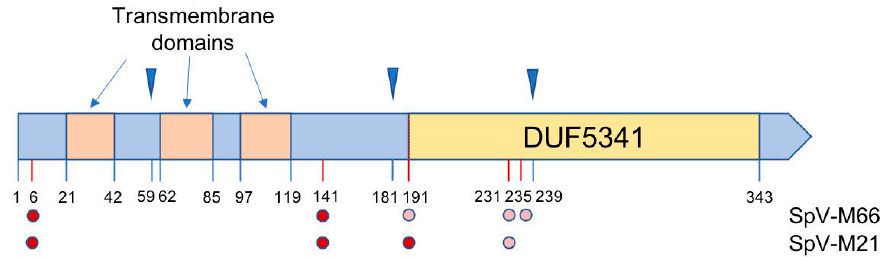
Figure 3. Features of the protein coded by SpV-M66. Blue triangles above the picture mark Kex2 sites. Predicted transmembrane domains and DUF5341 conservative Pfam family domain are marked within the picture. Dots below the picture mark putative glycosylation sites for K66 and K21 proteins, color intensity corresponds to the value of reliability index of the given position. Feature-linked positions of amino acids are indicated.